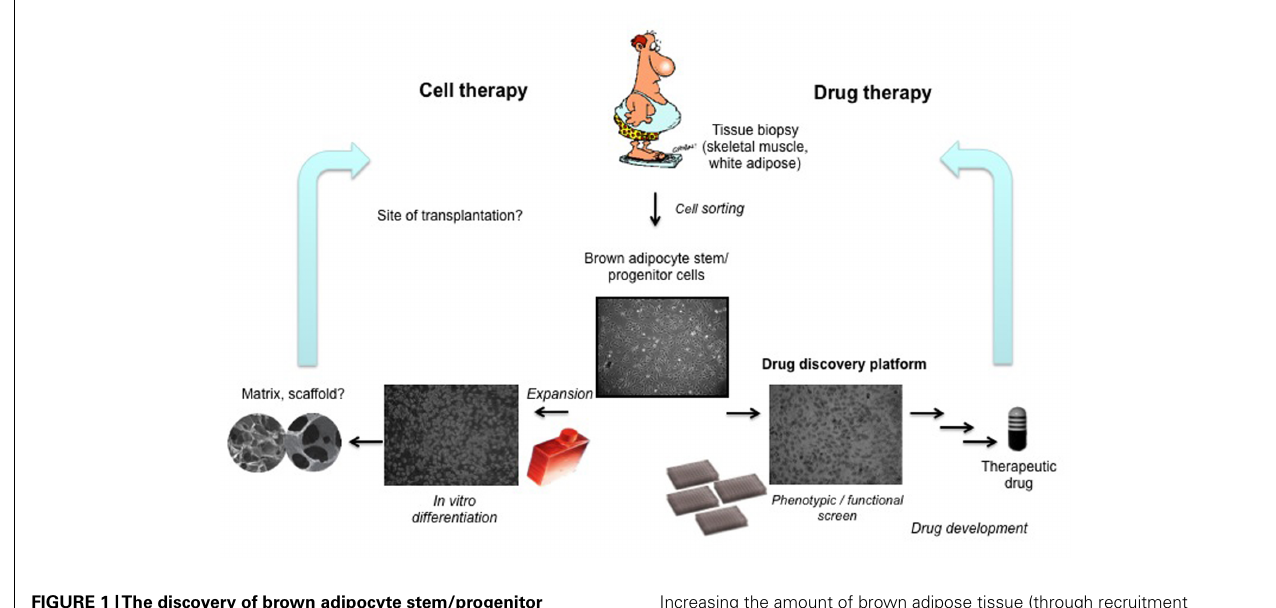
FIGURE 1 |The discovery of brown adipocyte stem/progenitor cells in humans of all ages provides an essential tool for drug discovery. The cells could also be expanded and induced to differentiate in culture, and transplanted back to the patient.